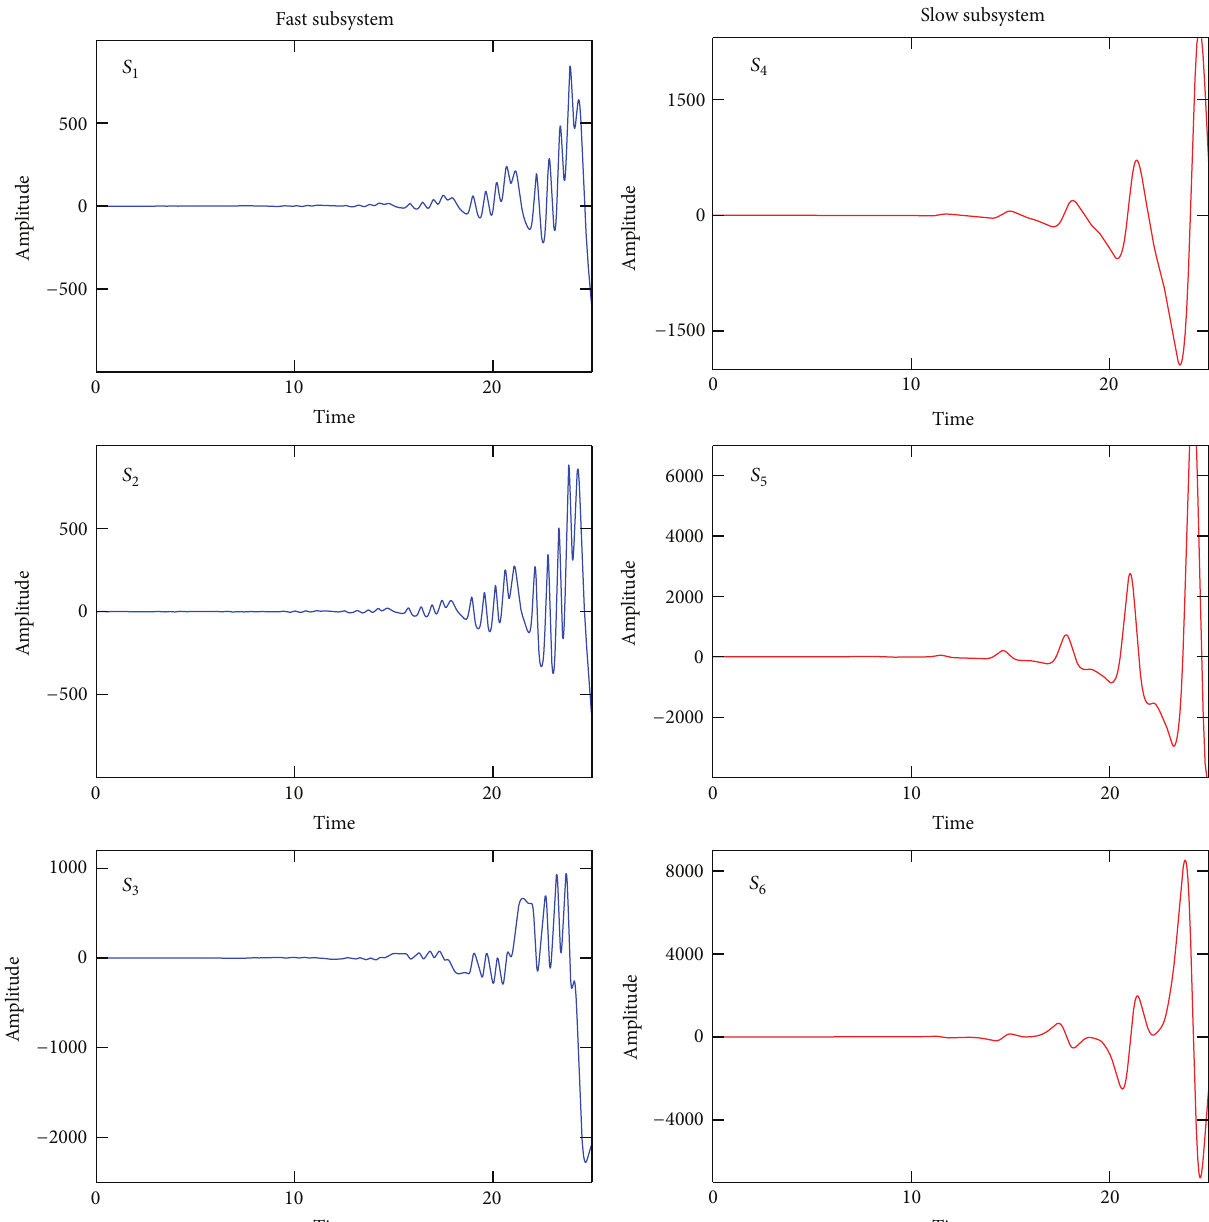
Figure 7: Time dynamics of sensitivity functions with respect to parameter 𝑟 on the interval [0, 25] for 𝑐 0 = 0.9 .